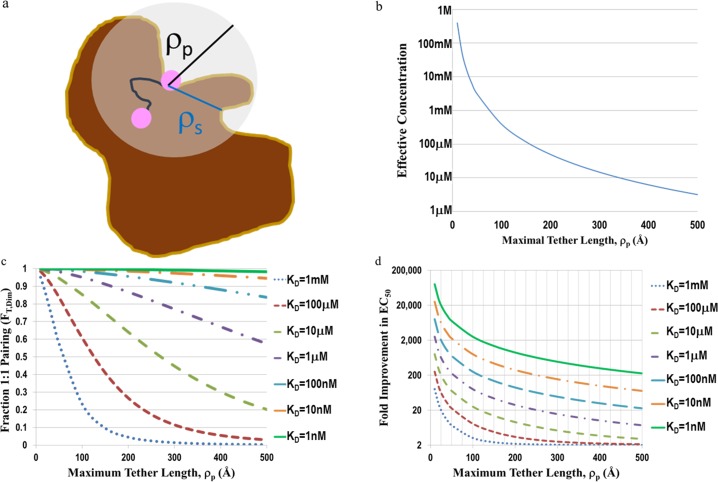
Significant increases in potency are possible for irreversibly connected monomers over a wide range of tether lengths.a) Model of the concentrating effect afforded by a tether. The target (brown) has two binding sites with a separation distance of ρs (blue line). One of the dimer’s ligands (pink) binds one target site while the other ligand is free in space. The fully extended dimer has a separation length ρp (black) between ligands. The sphere which encloses the space available to be sampled by the free ligand is grey. b) Semi-log plot of the effective concentration as a function of tether length from Eq 30 with ρp ≥ ρs c) Fraction of total target molecules which have both sites occupied by a single bivalent ligand (FT,Dim) as a function of tether length and dissociation constant for the monovalent ligand (KD) from Eq 28. d) Semi-log plot of fold improvement in the predicted EC50 for the bivalent ligand, two site target model relative to the predicted EC50 from the monovalent, single site target model as a function of tether length and KD.